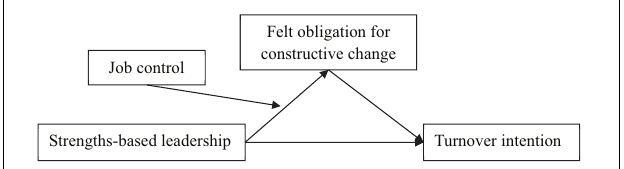
FIGURE 1 | The proposed conceptual